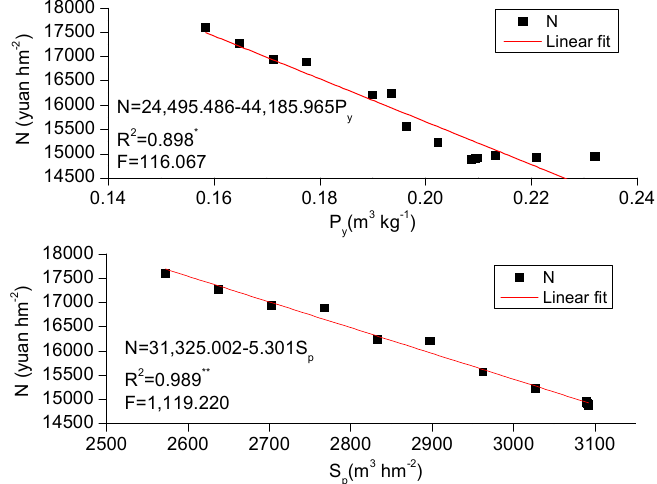
Figure 9. Relationships between water saving potential and net economic profit of maize. Note: N represents net economic profit, yuan hm − 2 ; P y represents water saving potential per yield, m 3 kg − 1 ; S p represents water saving potential per unit area, m 3 hm − 2 . * represents regression effect was significant; ** represents regression effect was remarkably significant.